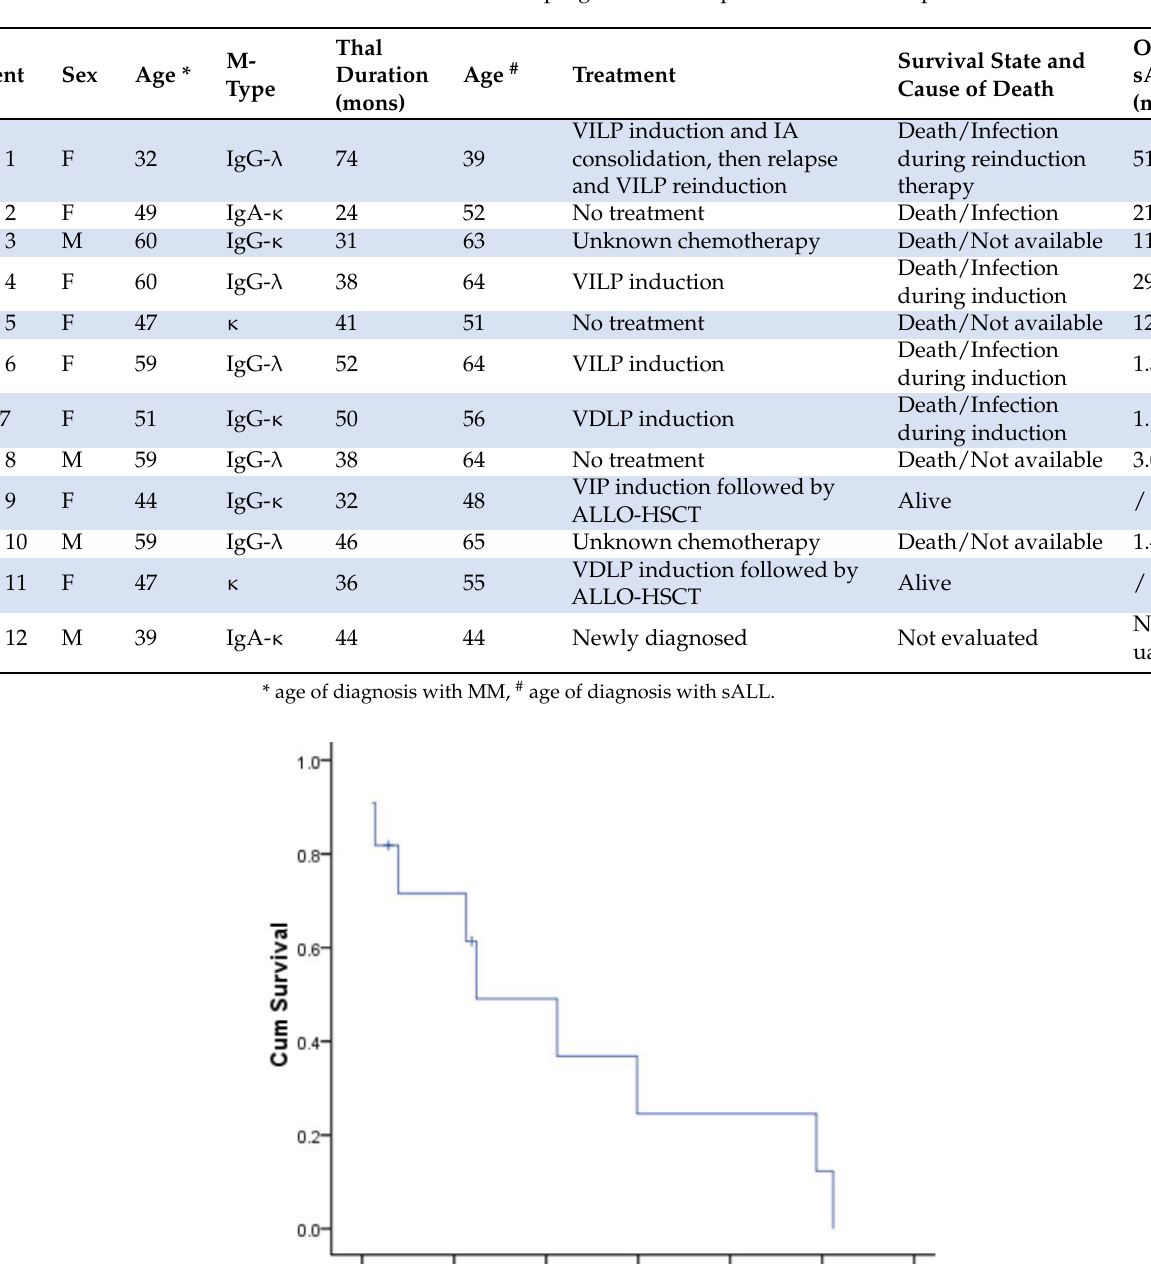
Table 2. Characteristics and prognosis of MM patients who developed sALL.